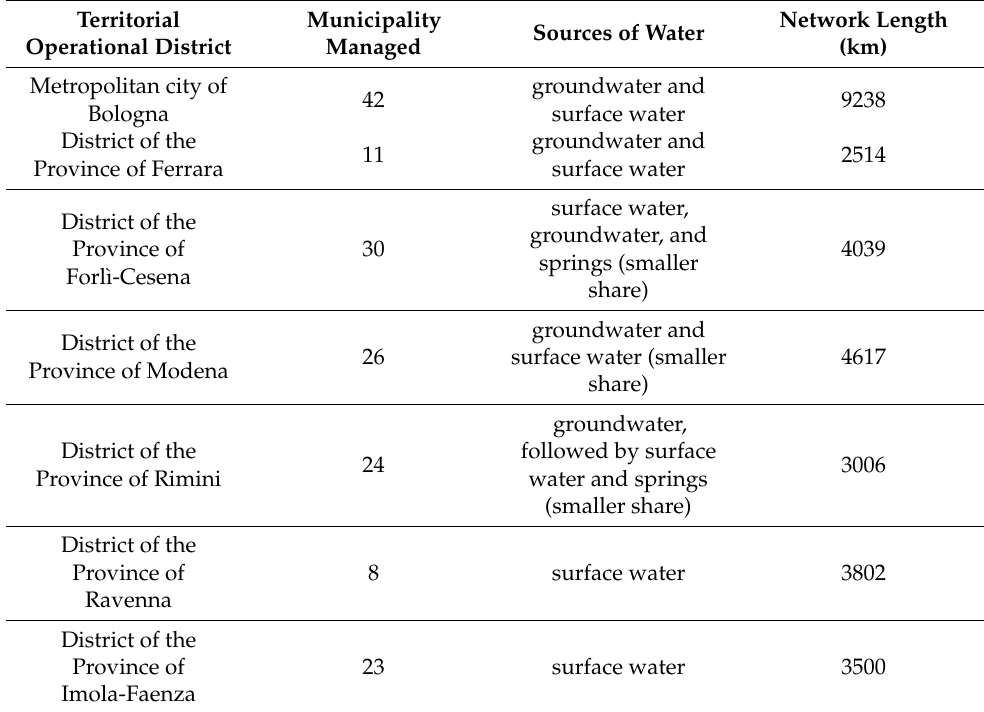
Table 1. Territorial operational districts and some characteristics of the